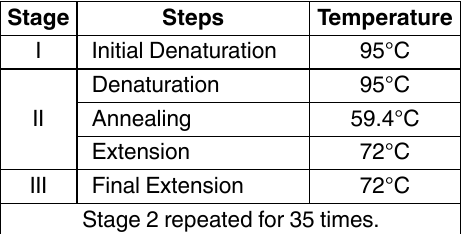
table 1. PCR conditions to amplify 317 bp of exon 11 of BRCA2